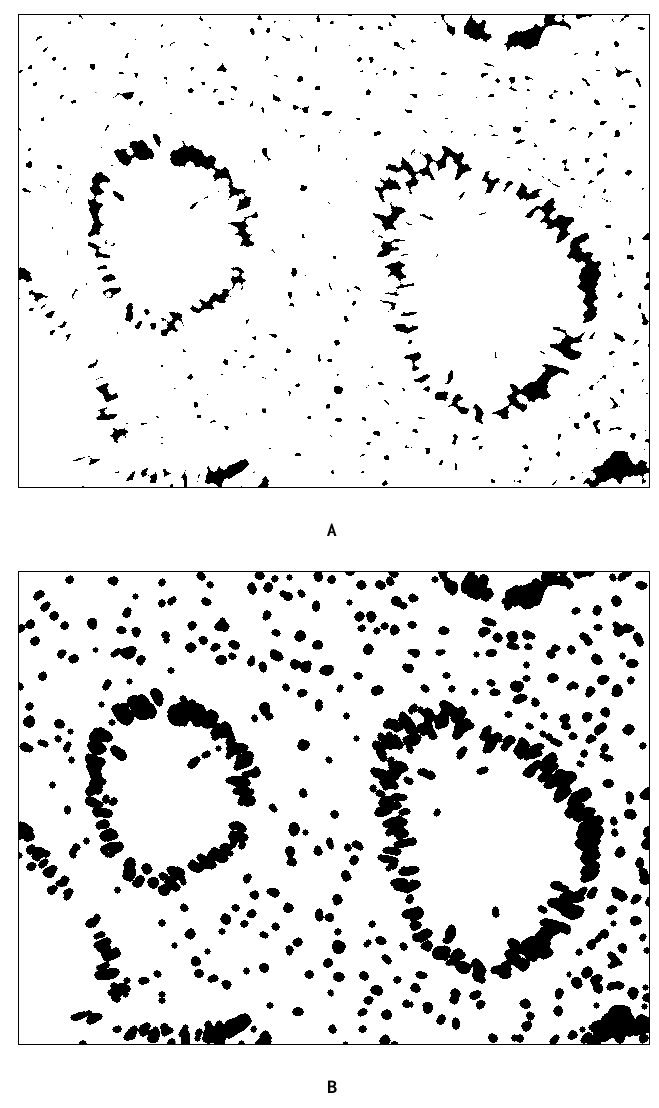
FIGURE 3. Morphological operations and histograms. (A) Erosion of image in Fig. 1 (B) by a round structure element of radius of three pixels; (B) conditional dilation of image in (A) by a round structure element of radius of three; (C) histogram of size of detached regions; (D) histogram of number of regions vs. region size; (E) histogram in (D) smoothed by a low-pass